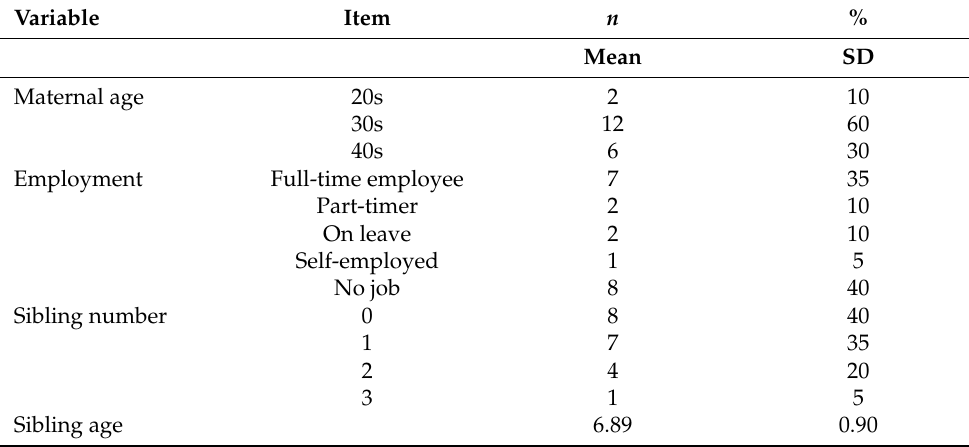
Table 1. Demographic of study participant’s family ( n = 20).